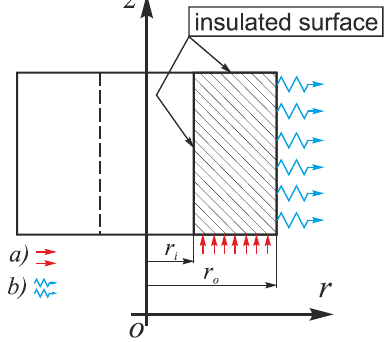
Fig. 1. Boundary conditions for heat transfer in the hollow cylinder. a) heat flux, b) convection.